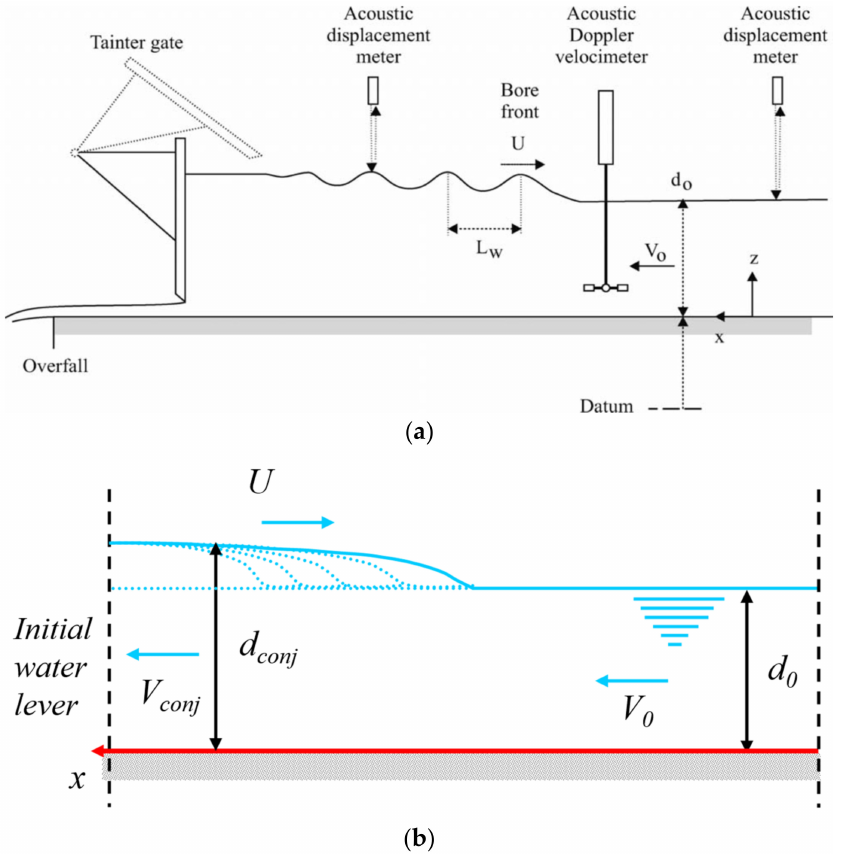
Figure 1. Definition sketch of a positive surge (after [16,17]). Laboratory flume ( a ), Surge develop- ment ( b ).